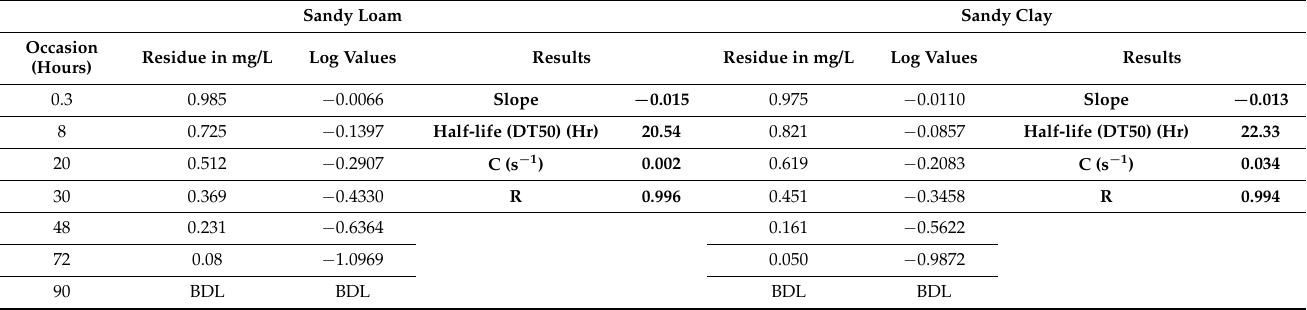
Table 8. Kinetic parameters for thifluzamide photocatalytic decontamination in soil under sunlight. Sandy Loam Sandy Clay